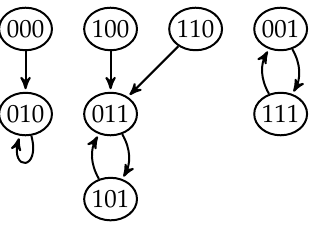
Figure 8. Phase portrait of the system F ( x 1 , x 2 , x 3 ) = ( x (cid:48)